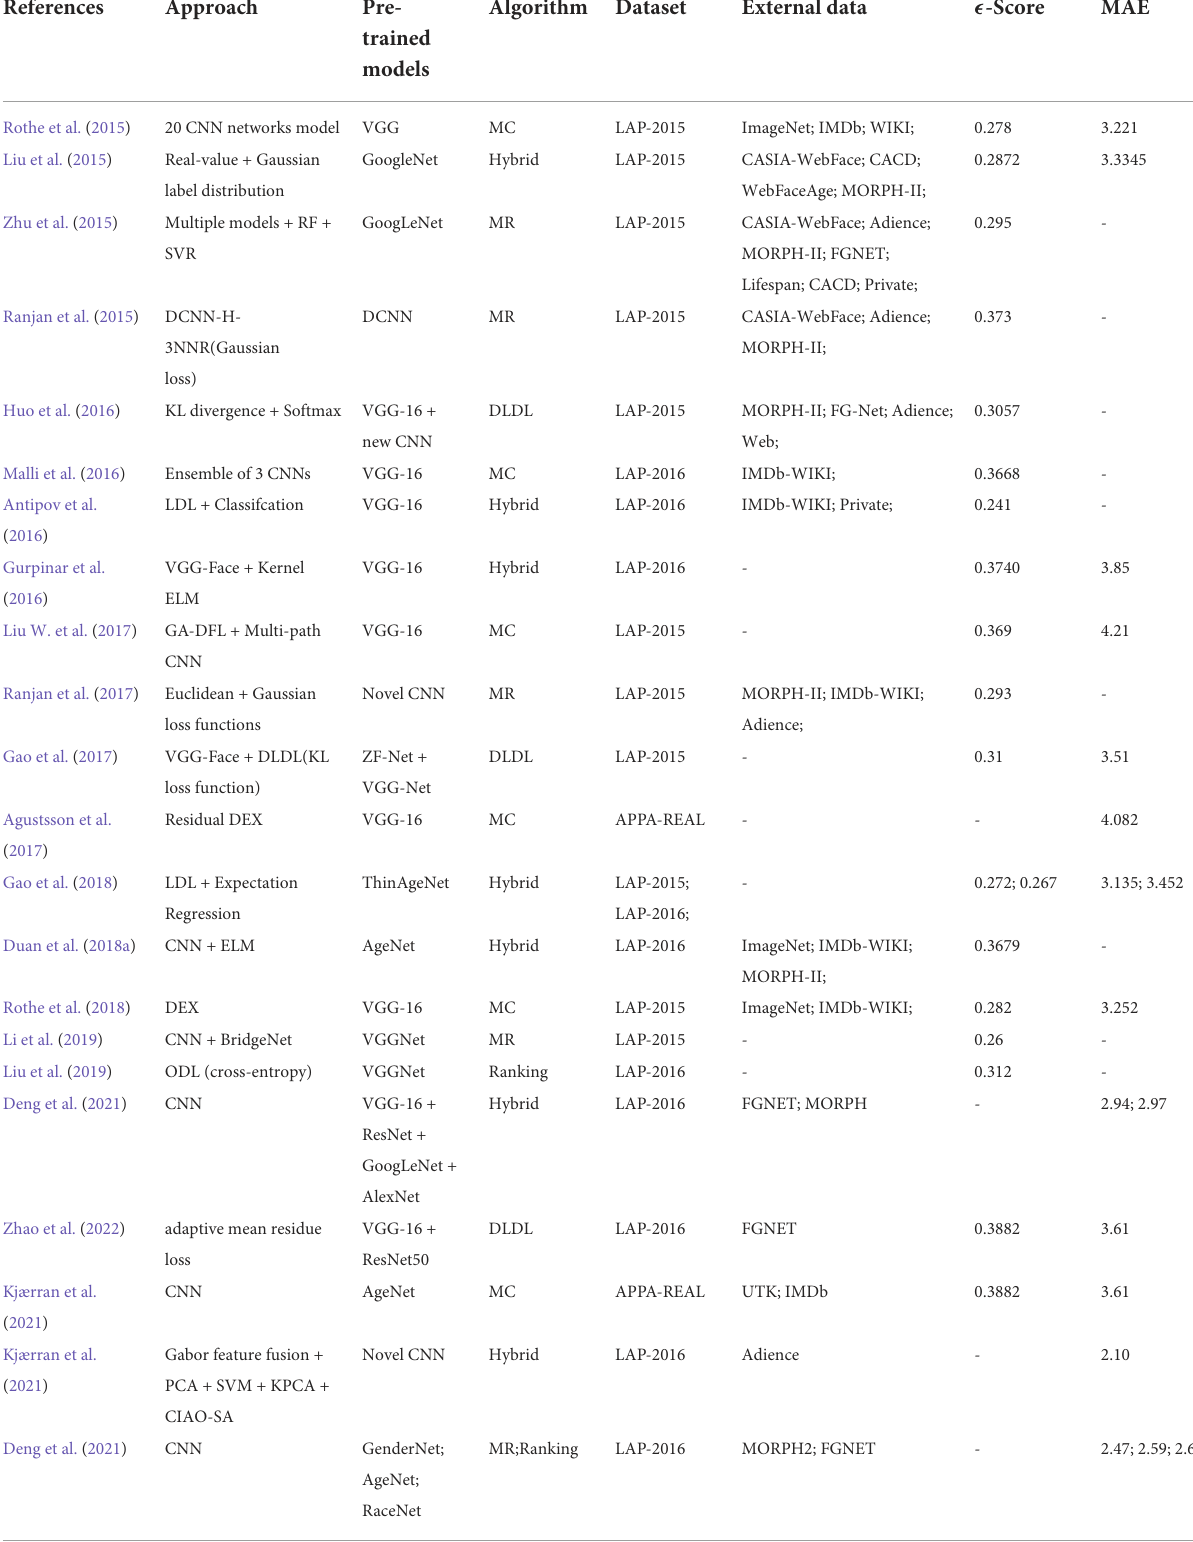
TABLE 2 Description of state-of-the-art convolutional neural network (CNN) architectures in apparent age